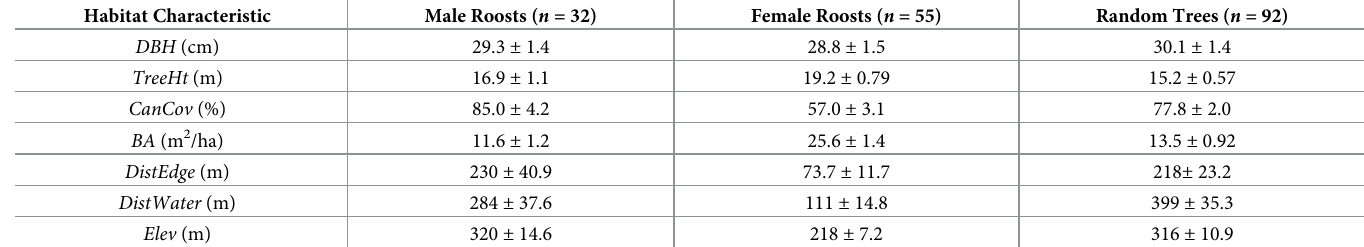
Table 2. Characteristics of roost trees used by male and female northern myotis, along with randomly sampled trees, in central Pennsylvania. Data presented are mean ( ± SE). See text for descriptions of habitat measures. Habitat